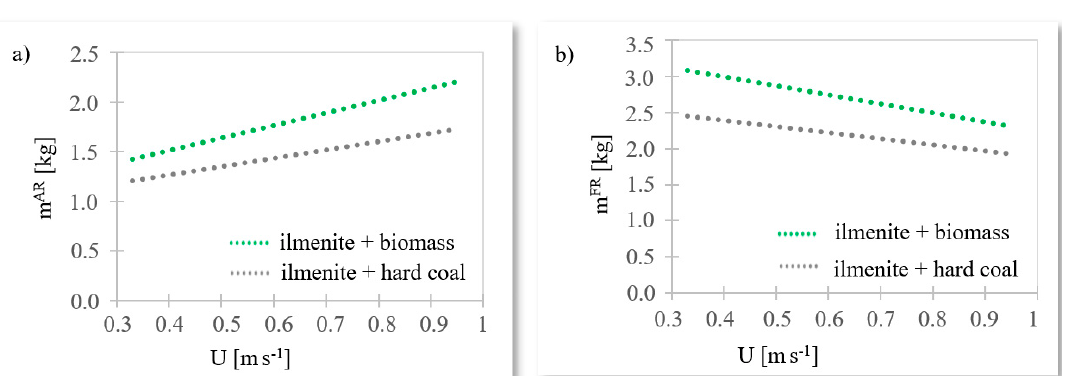
Figure 15. The total mass of solids in the fuel reactor ( a ) and air reactor ( b ) versus the superficial gas velocity in the FR.